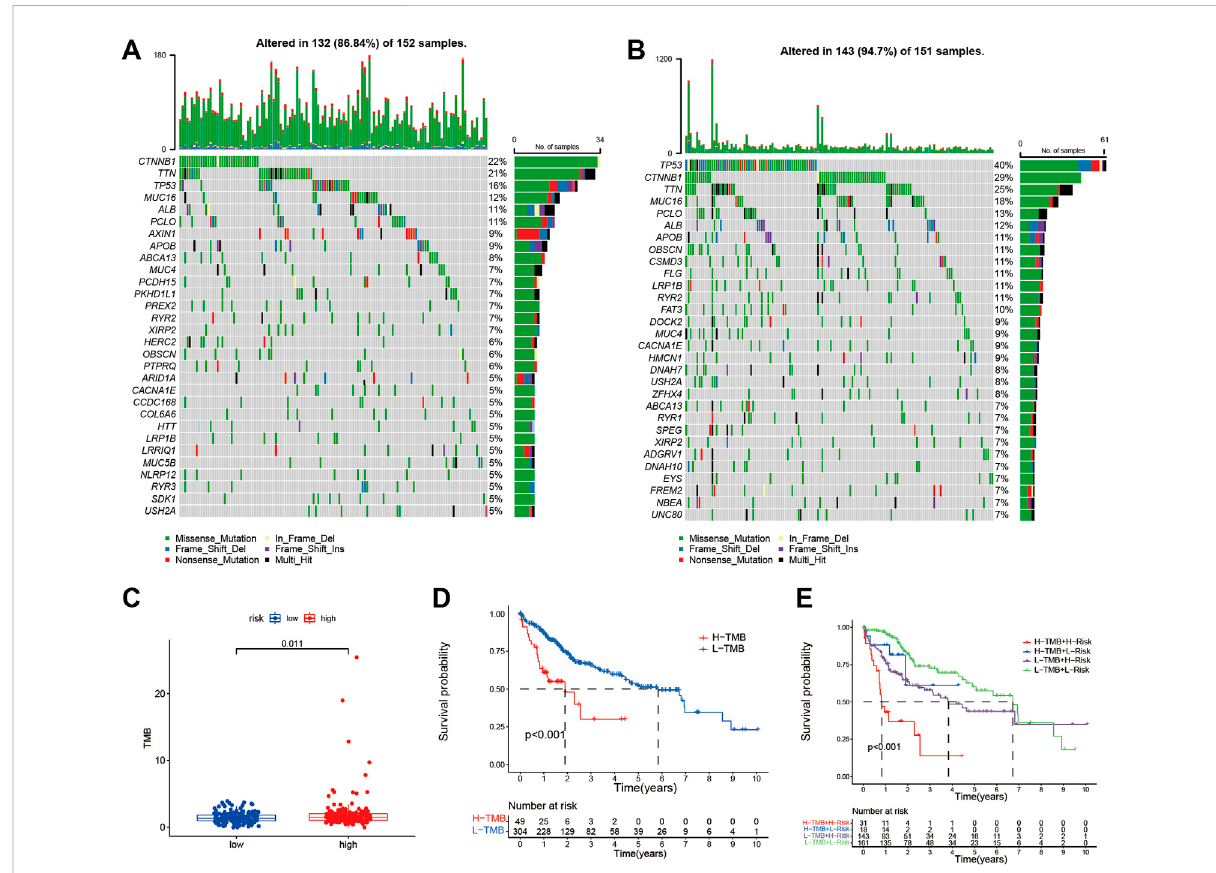
FIGURE 6 ThesomaticmutationsandTMBinrisksignature.Thewaterfallplotshowsthetop30geneswithhighmutationfrequencyinthehigh-riskgroup (A) andlow-riskgroup (B) intheTCGAcohort. (C) ThebarplotshowstheTMBbetweenthehigh-andlow-riskgroupintheTCGAcohort. (D) Kaplan- Meier curve analysis shows survival difference between high and low TMB groups. (E) Kaplan-Meier curve analysis showed survival differences among patients classi fi ed according to TMB and risk group in the TCGA